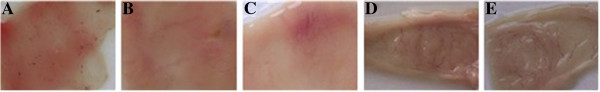
Macropathological observations in all groups. (A&B) Defective cecal mucosa in the control group, with bleeding, edema and disappearing of vascular lakes. Colon mucosa adjacent to the cecum with edema and ulcer; (C) Cecal mucosa of the empty plasmid group, with edema, scattered bleeding points and erosion; (D) Cecal mucosa of the secreted-protein plasmid group; and (E) Cecal mucosa of the membrane-anchored plasmid group.